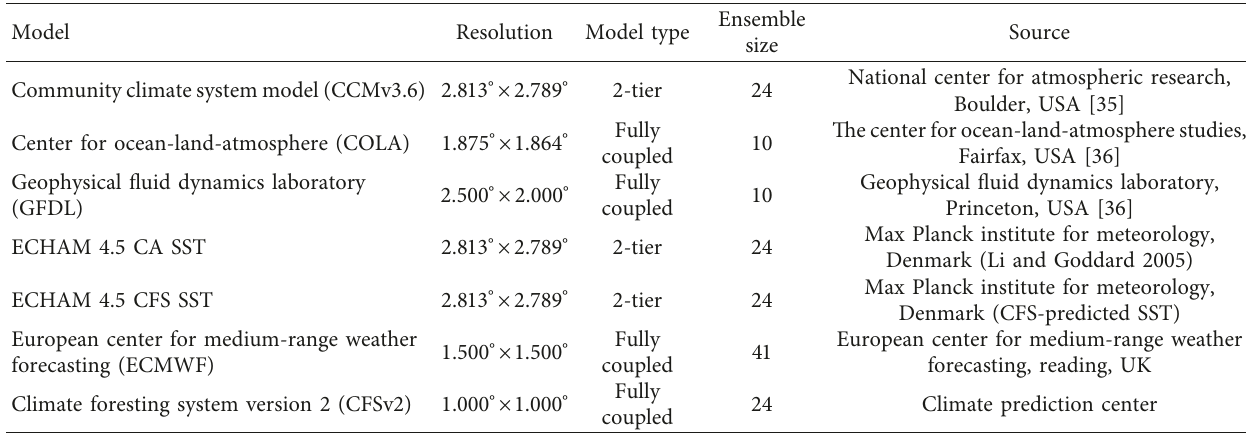
Figure 2: Annual cycle of rainfall climatology for all six homogeneous zones (bar graph) and overall Myanmar (line graph). Table 1: Details of GCM datasets